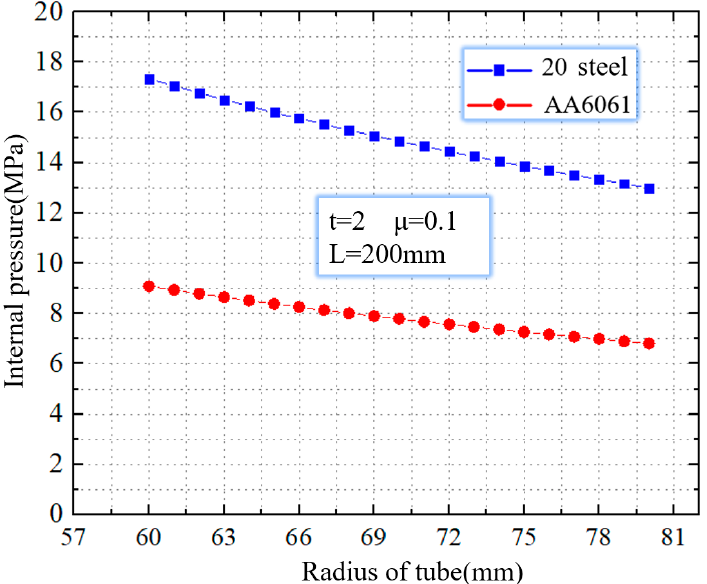
Figure 7. The critical rupture pressure of 20 steel and AA6061.